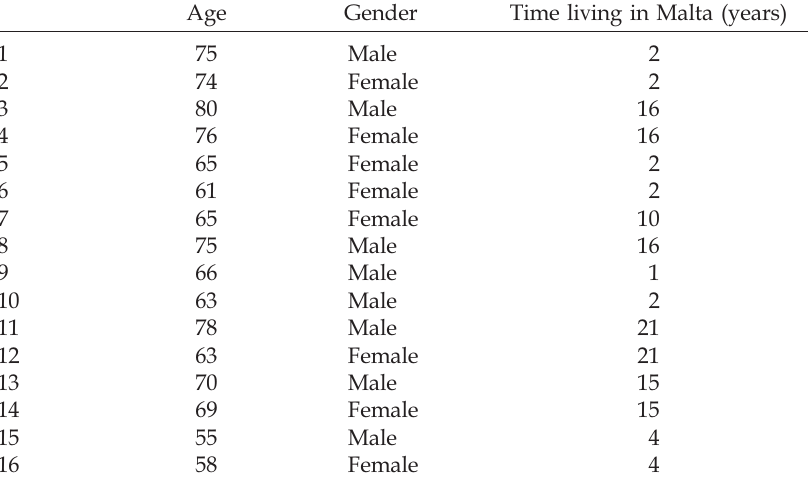
Table 1. Participants Age Gender Time li v ing in Malta